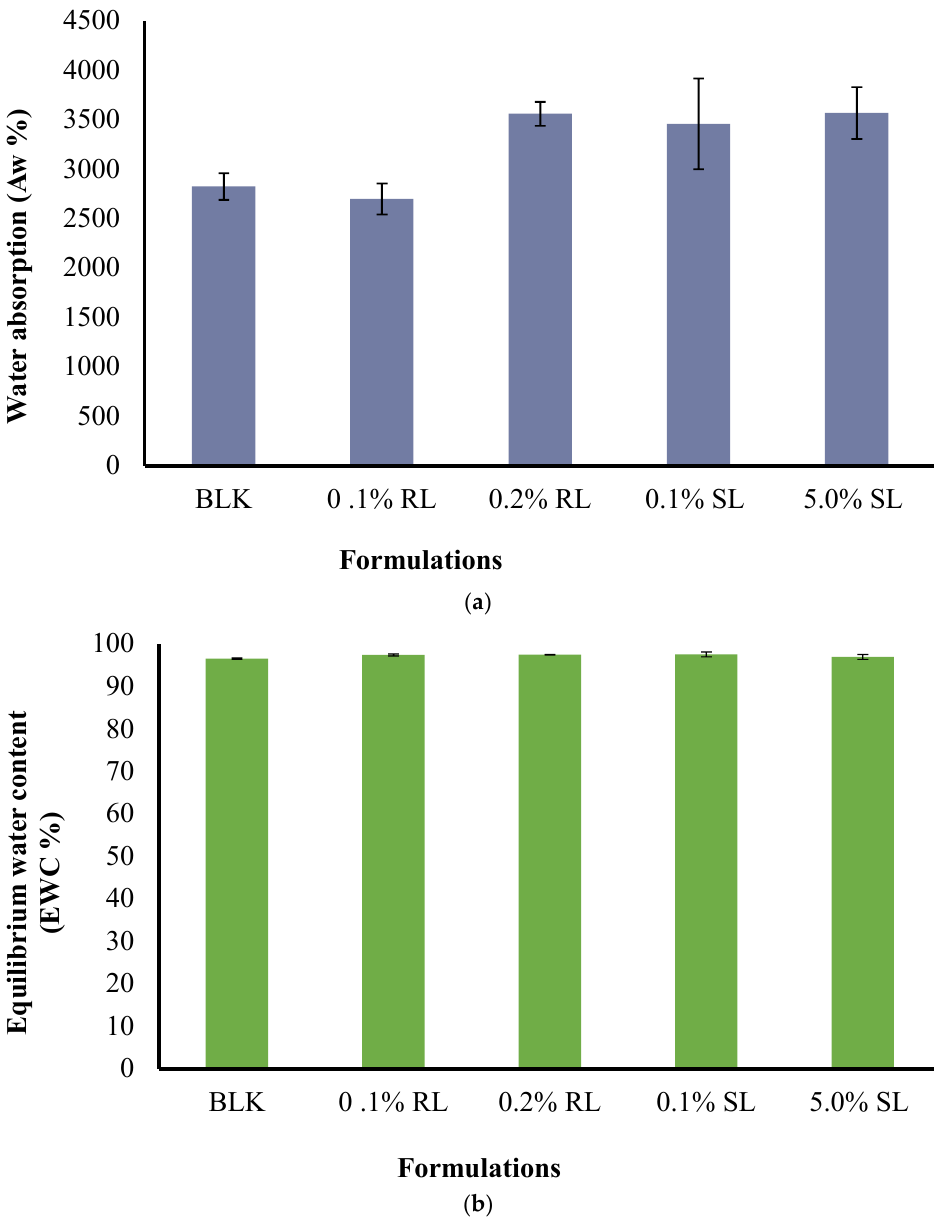
Figure 7. Comparison of ( a ) the water absorption ( A w) and ( b ) the equilibrium water content ( EWC ) of optimized BLK and BSs loaded wafers.